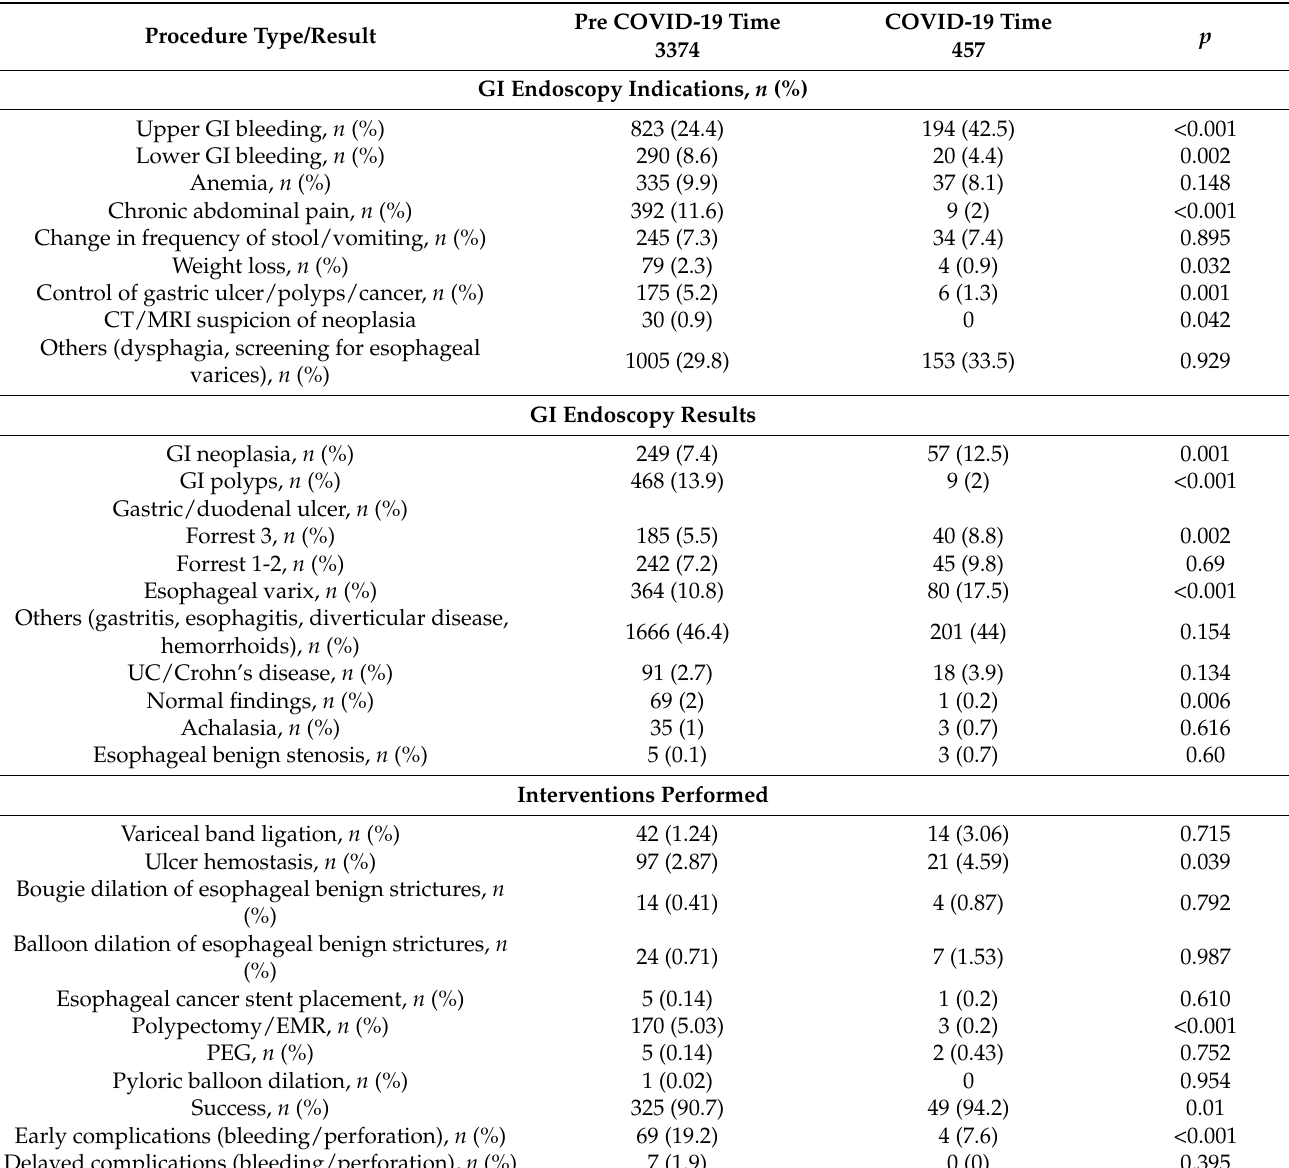
Table 2. Analysis of upper and lower GI endoscopy before and during the COVID-19